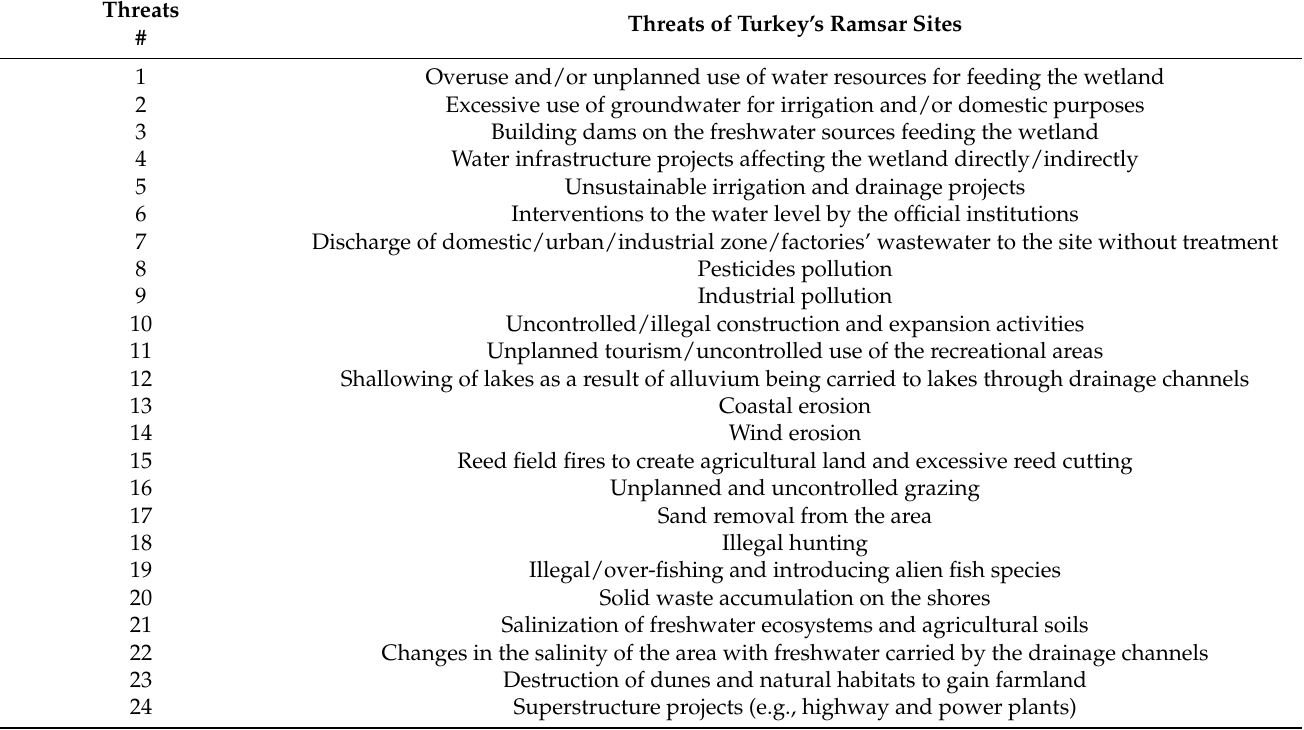
Table 3. The main factors affecting the Ramsar sites of Turkey